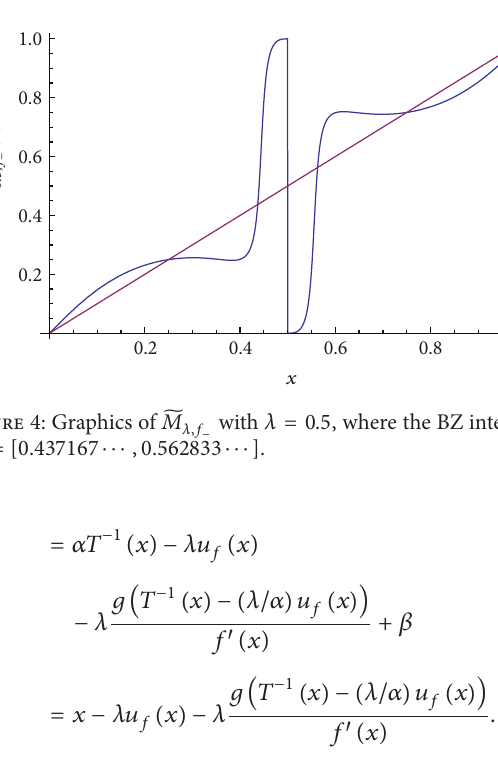
Figure 3: Graphics of 𝐼